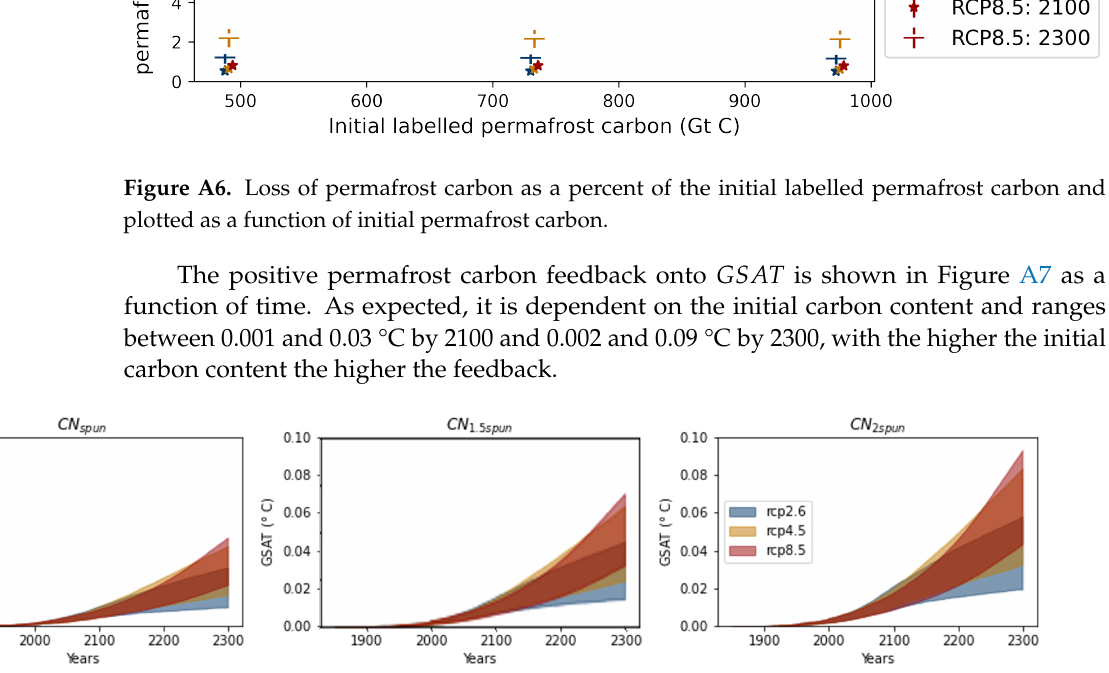
Figure A7. Permafrost carbon feedback temperature onto GSAT for the different JULES configura- tions and